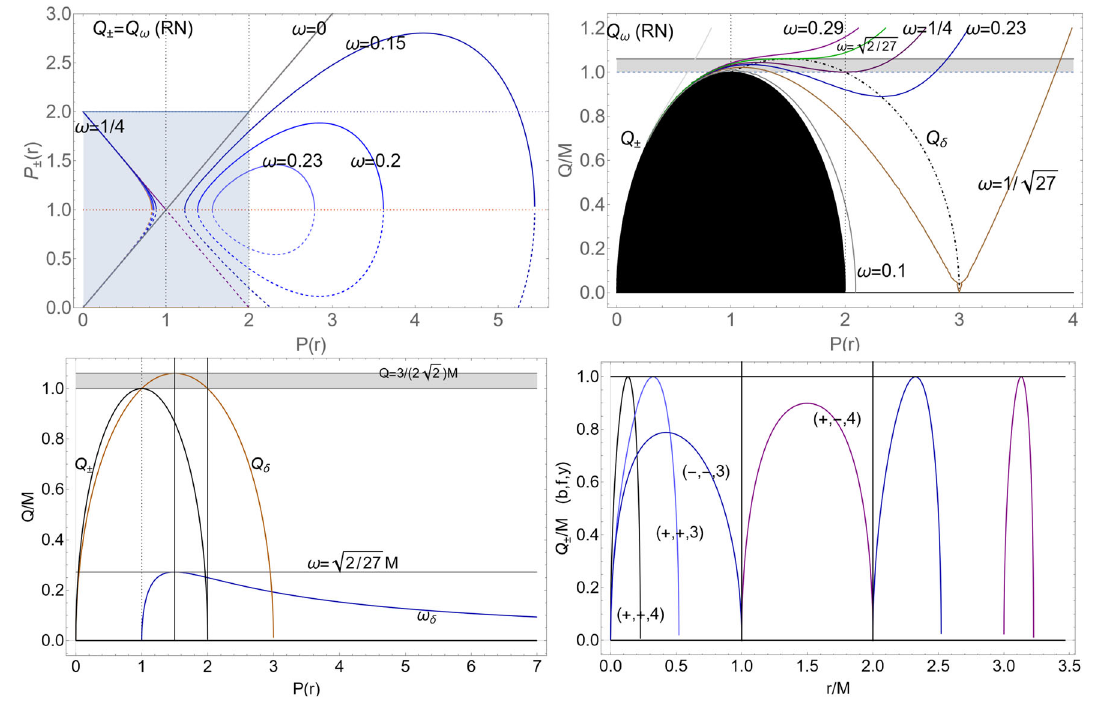
Fig. 19 Deformation of the Reissner–Nordström geometry. Upper left panel: Solution P ± ( r ) : Q ± = Q ω of Eq. (A.4), as function P ( r ) ≡ b ( f r ) y = o for different frequencies ω signed on the panel, the limiting frequency ω = 1 / 4 and ω = 0 where Q ± is the RN BH horizon curve in the plane Q − r . Shaded region is the horizons region where P ( r ) ∈ [ 0 , 2 ] . Upper right panel: black region is the BH in the extended plane, where Q ± is the horizon curve in the extended plane, Q δ in Eq. (A.5) is the curve of minimum points of the metric bundles.